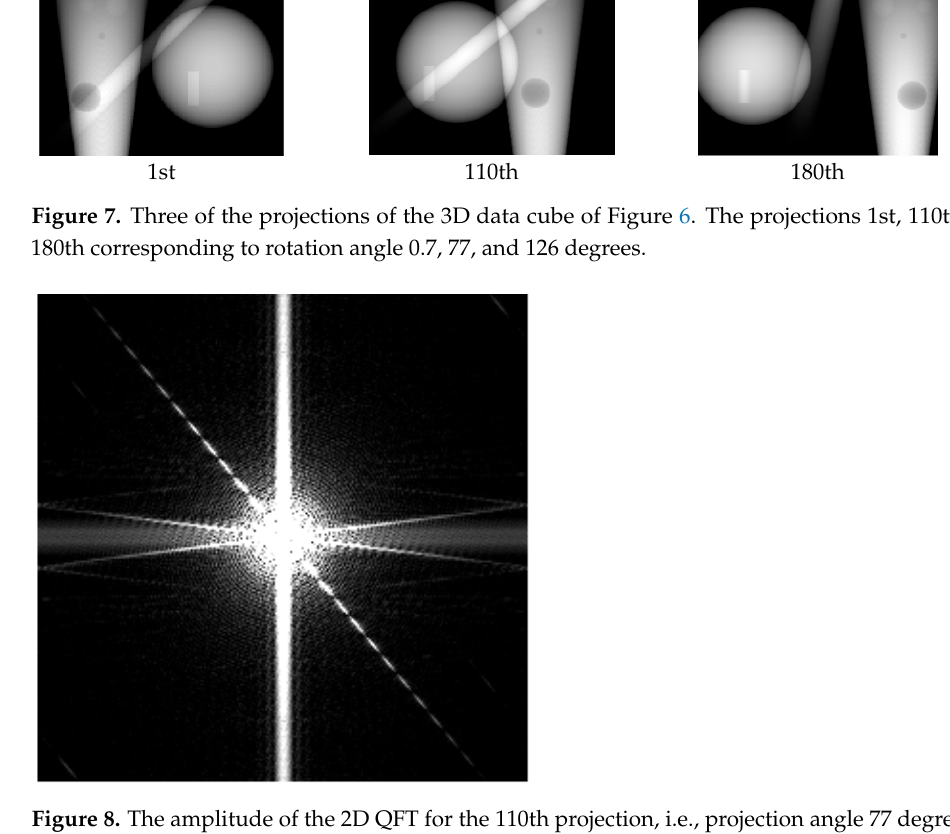
Figure 8. The amplitude of the 2D QFT for the 110th projection, i.e., projection angle 77 degrees. The whole procedure includes the following steps: 1. Projections acquisition as those shown in Figure 7. 2.